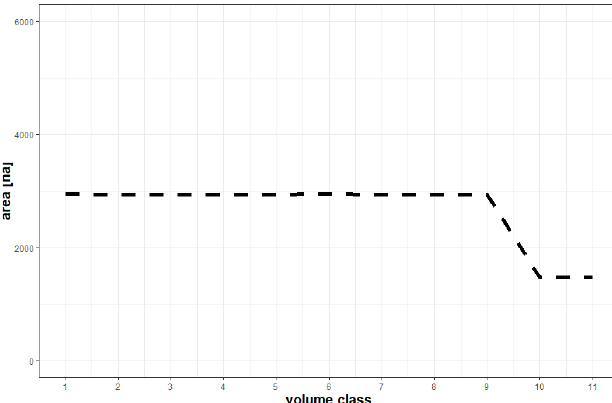
Figure 2. The parameter environment of the EFDM simulation runs [7].